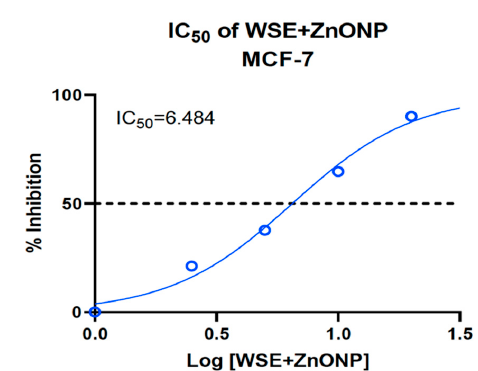
Figure 6. As-prepared ZnONPs using WSE reduced the IC50 value on MCF-7 breast cancer cell lines. ( a ) A comparative graphical representation of the percentage inhibition of the MCF-7 cells by the test samples and ( b – d ) individual IC50 calculations for each treatment. n = 3, mean ± SEM, p value of <0.05 was considered to be significant, ** p = < 0.002, *** p = < 0.001, ns = not significant.